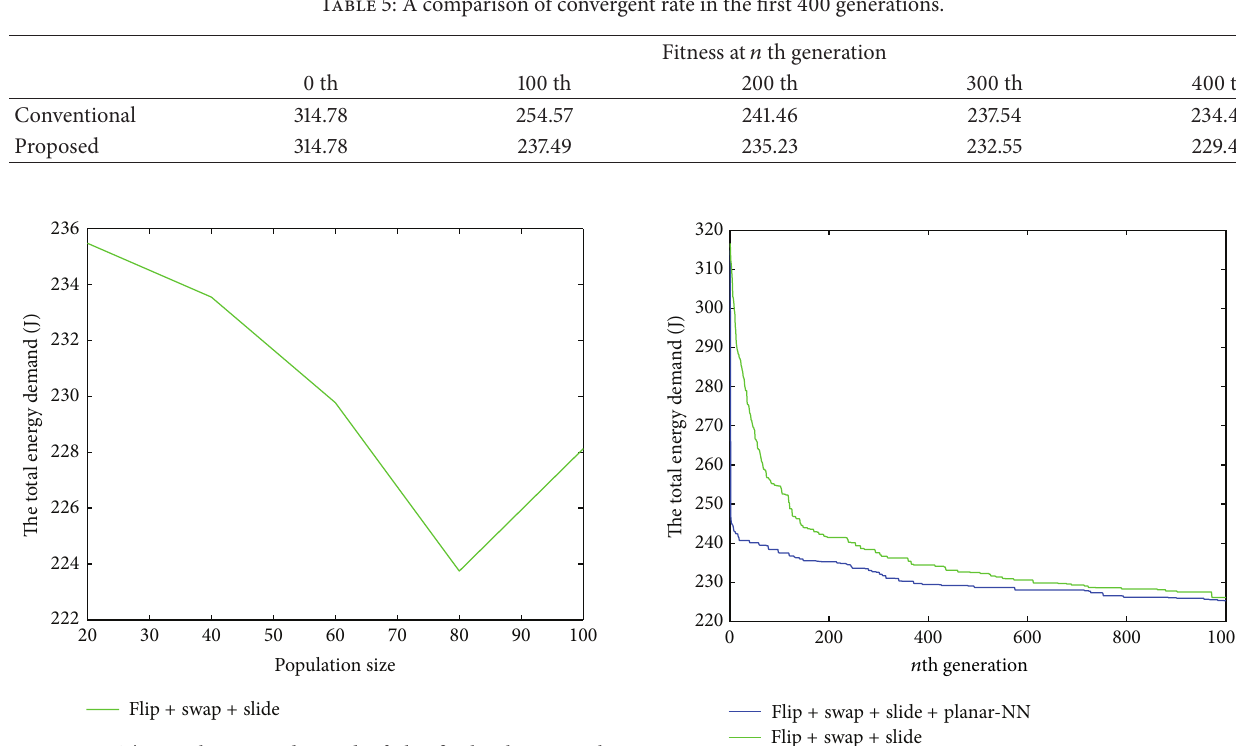
Figure 19: The total energy demand of the final solution with different population sizes. Figure 20: The effect of different genetic operators on the best path given by the proposed